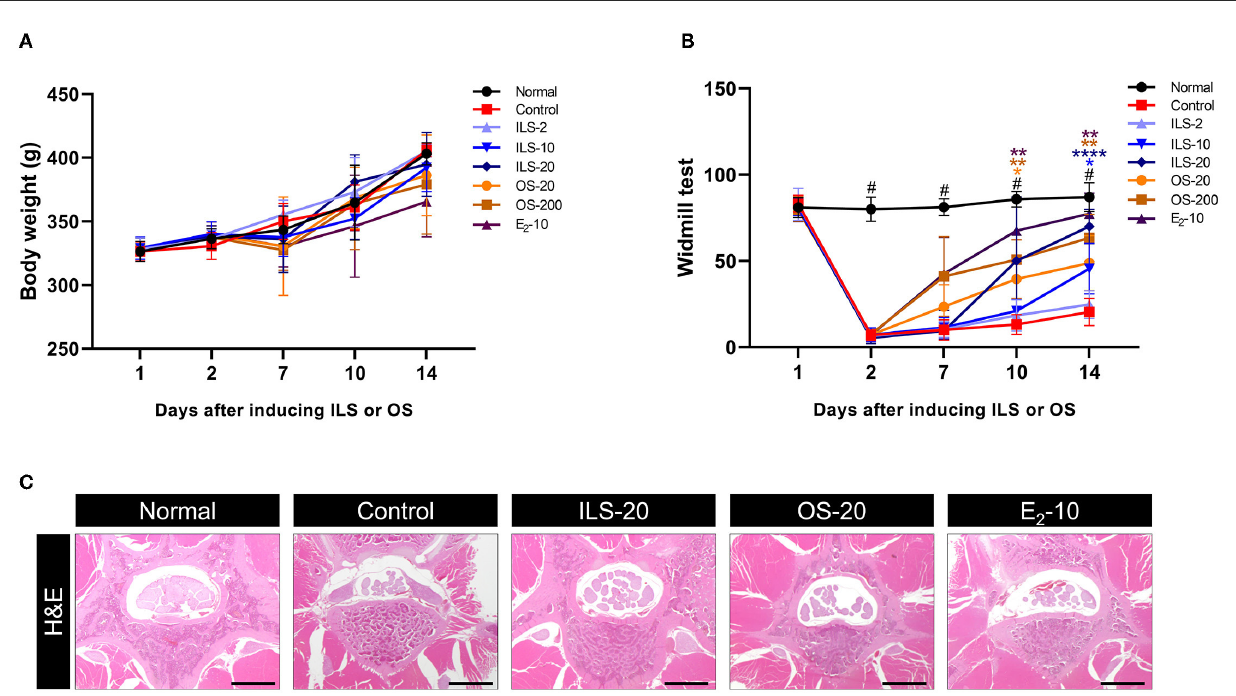
FIGURE1 Body weight, behavior, and histological assessments. (A) Body weight curve of each group for 14 days. (B) Behavioral assessment of each group using the windmill test for 14 days. (C) H&E-stained images of the spinal structure following the administration of Shinbaro 2 with two routes in LDH rats. Scale bar = 200 µ m. Data are expressed as mean ± SEM. Significant differences indicated as having # a p < 0.001 compared vs. the blank group, * a p < 0.05, ** a p < 0.01, and **** a p < 0.0001 vs. the control group were analyzed via one-way ANOVA with Tukey’s post-hoc test.